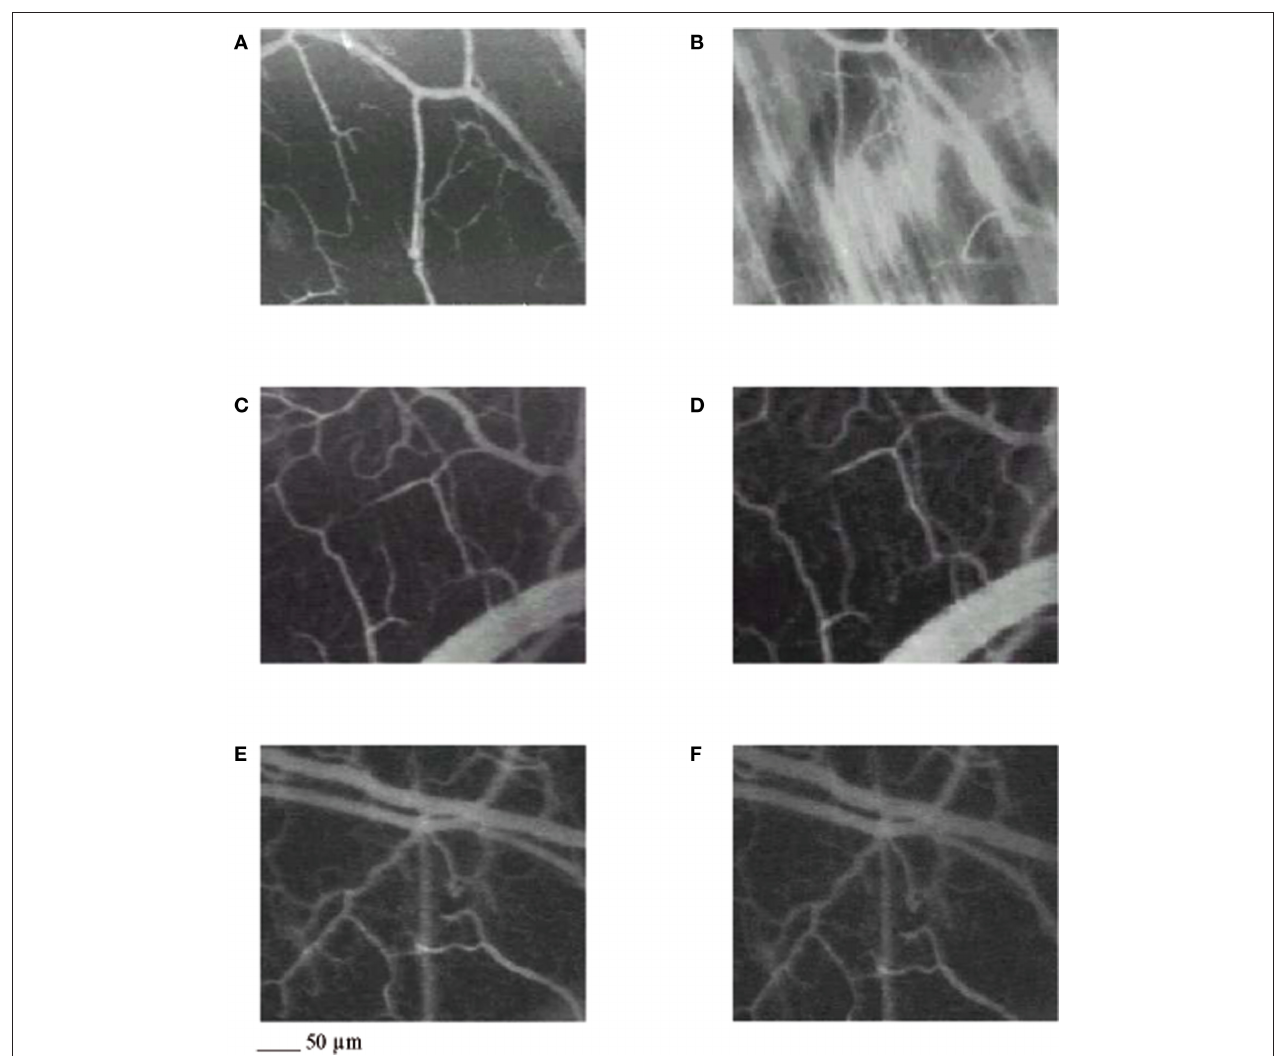
FiGuRE 1 | Computer-assisted images of a microvascular networks in control hamster under baseline conditions (A) and at the end of reperfusion (B) ; in hamster treated with pLc, 5 mg/100 g body wt intravenously injected (C,D) , and in hamster treated with pLc 2.5 mM/l topically applied (E,F) , at the